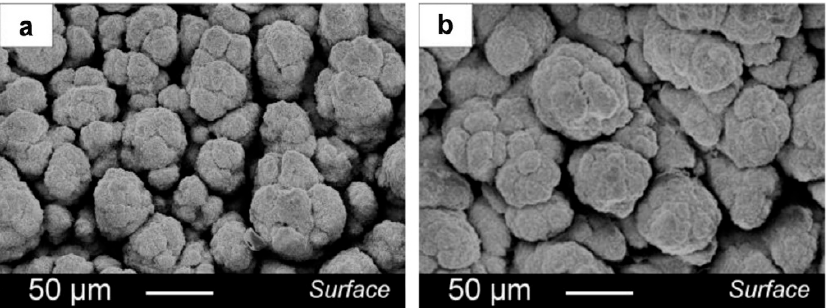
Figure 4. Substrate roughness influence in coating microstructure: ( a ) Ra ( b ) 2.5Ra (adapted from [10])